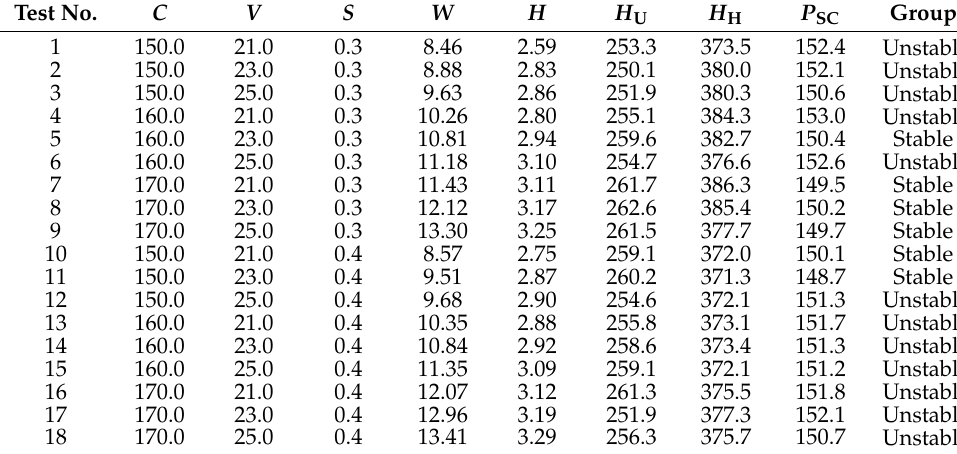
Table 9. Learning data for discrimination model.